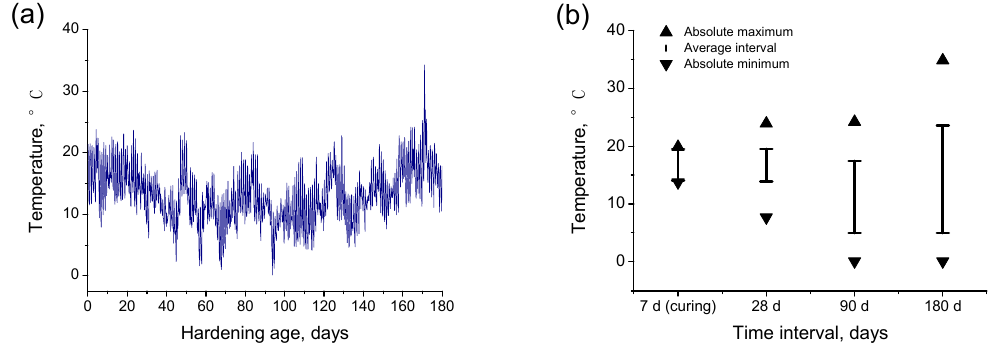
Figure 2. ( a ) Temperatures registered during the exposure period; ( b ) Absolute maximum, absolute minimum and interval of average temperatures at which the samples were exposed during the seven-day curing period and for those samples tested at 28, 90, and 180 days, respectively.